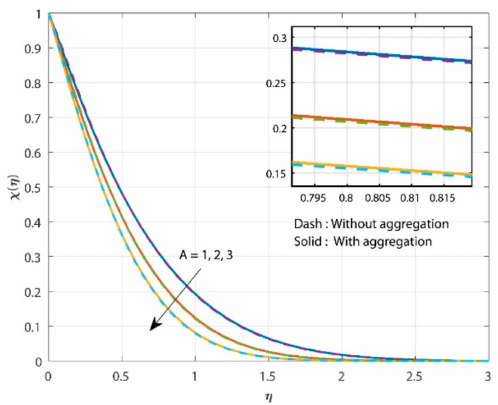
Figure 5. Influence of acceleration parameter on χ . The variation in the rotational parameter ( λ ) on the primary velocity f (cid:48) profile is shown in Figure 6. The increase in λ will accelerate the primary velocity f (cid:48) . This is due to the rise in the λ , which includes additional momentum to the boundary layer, which results in a decline in the thickness of the boundary layer, causing the fluid to accelerate. It is also observed that nanoparticles without aggregation have lower velocity than nanoparticles with aggregation.